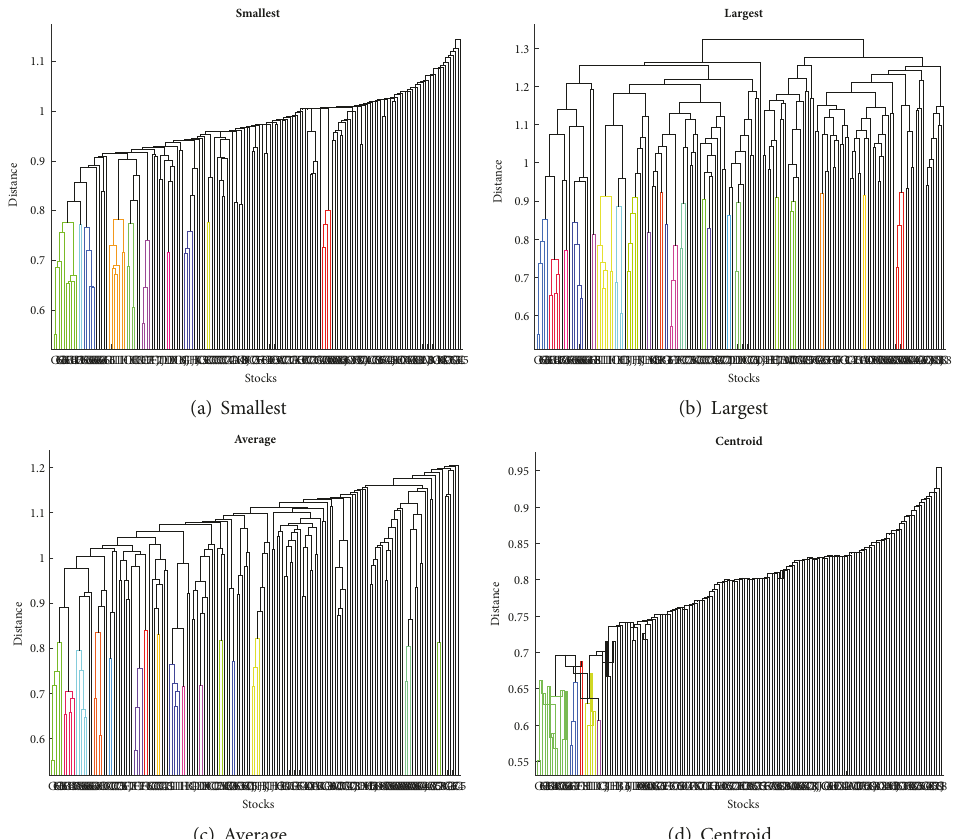
Figure 10: CSI163 dendrogram hierarchical cluster trees extracted with different distance definitions in (a) smallest distance for stock pairs, equation(8);(b) largest distancefor stockpairs, equation (9); (c)averagedistancefor stockpairs, equation (10); (d) distancebetween centroids for clusters,equation (11). Thecolorthreshold is 0.7. All stockswhoselinkage valuesareless than this threshold would becolored with aunique color. As shown in the figures, different distance definitions extract different dendrogram hierarchical cluster trees whereas the same color threshold generates different results. We see that the largest distance definition reveals more details of